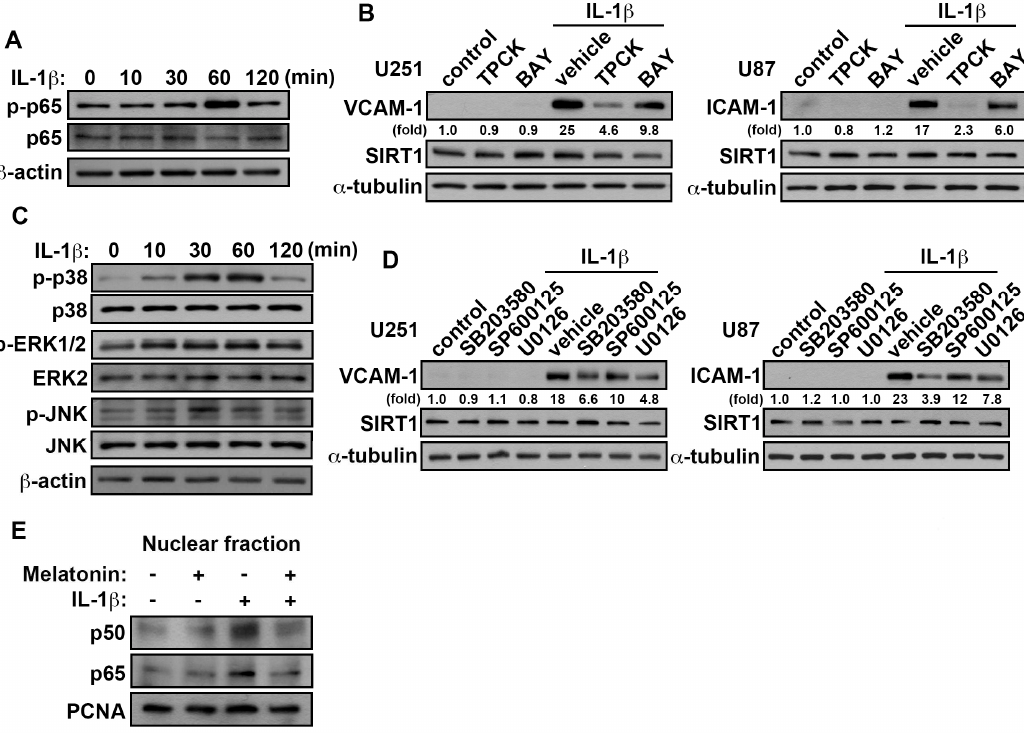
Figure 7. p38 / p65 signaling pathways are involved in the VCAM-1 and ICAM-1 expression were induced by IL-1 β in GBM. ( A ) GBM cells were added with IL-1 β (3 ng / mL) for di ff erent time periods (10, 30, 60 or 120 min) and p-p65 expression were analyzed by western blotting. ( B ) Cells were added to TPCK (10 µ M) and BAY 11-7082 (3 µ M) for 45 min then administrated with IL-1 β (3 ng / mL) for another 24 h. The expression levels of VCAM-1, ICAM-1 and SIRT1 were analyzed by western blotting. ( C ) GBM cells were added with IL-1 β (3 ng / mL) for various time periods (10, 30, 60 or 120 min), and p-p38, p-ERK1 / 2 and p-JNK expression was assessed using western blotting. ( D ) U251 and U87 were added with SB203550 (10 µ M), SP600125 (10 µ M) and U0126 (1 µ M) for 45 min and added with IL-1 β (3 ng / mL) for another 24 h. The expression levels of SIRT1, VCAM-1 and ICAM-1 were assessed using western blotting. ( E ) GBM cells were pretreated with melatonin (0.5 mM) for 45 min and added with IL-1 β (3 ng / mL) for another 2 h. The nuclear extracts from GBM cells were subjected to western blotting. Expression levels of p50 and p65 was determined using western blotting. PCNA was used as nuclear internal controls. The values are presented as mean ± S.E.M. (representative of independent experiments = 3).